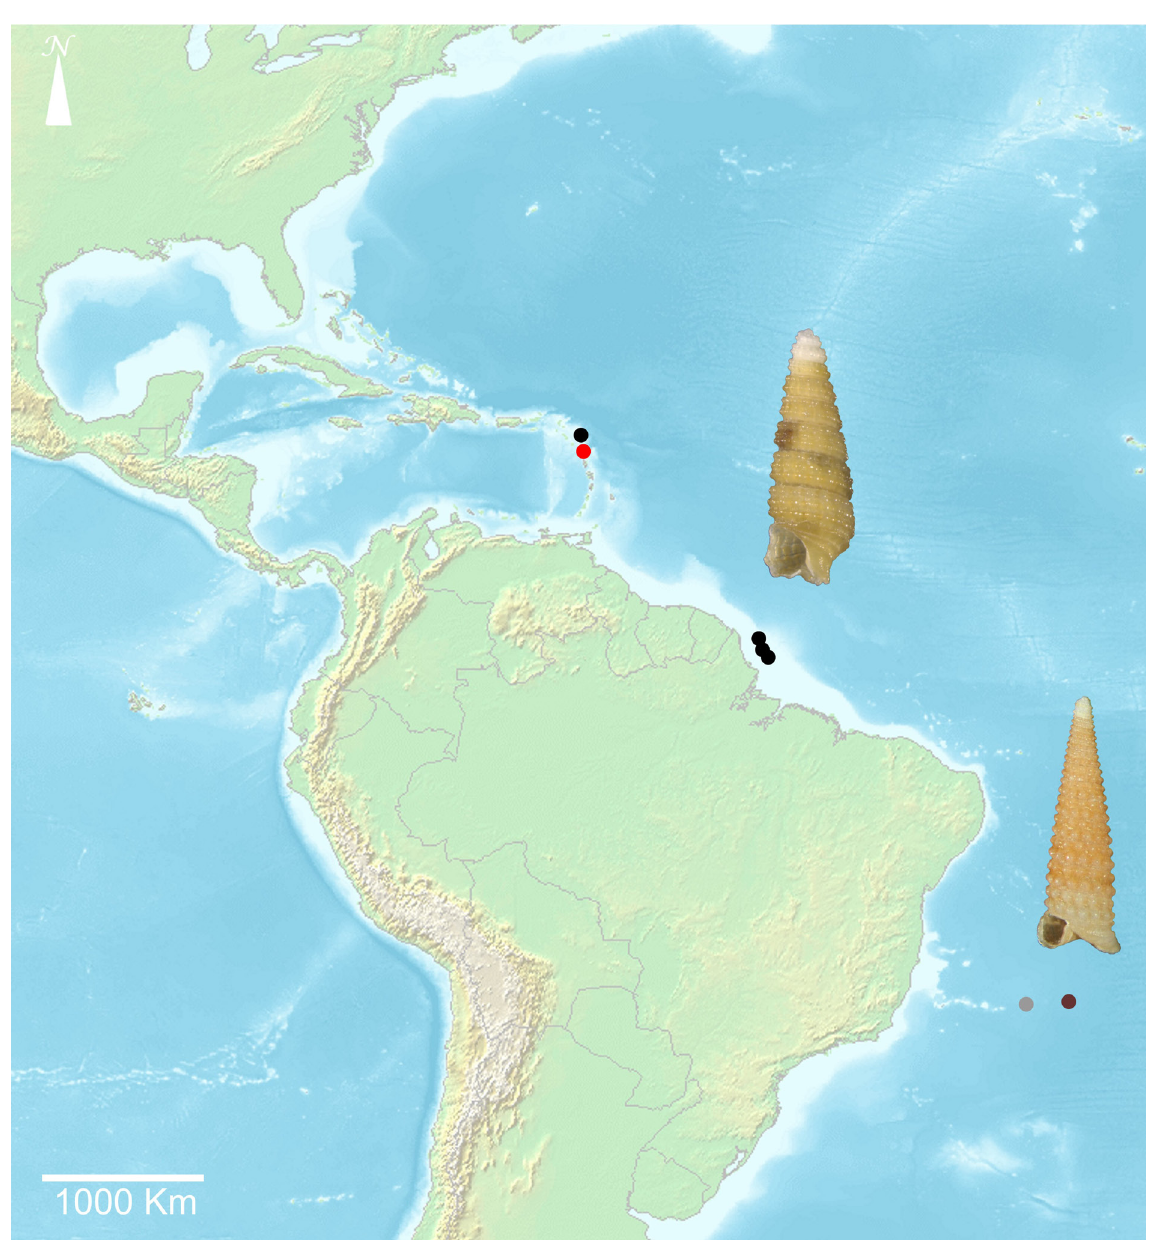
Fig. 50. Distribution map of Isotriphora tricingulata Rolán & Fernández-Garcés, 2015 (red circle = type locality; black circles = additional localities) and Isotriphora onca Fernandes, Pimenta & Leal, 2013 (brown circle = type locality; gray circle = additional